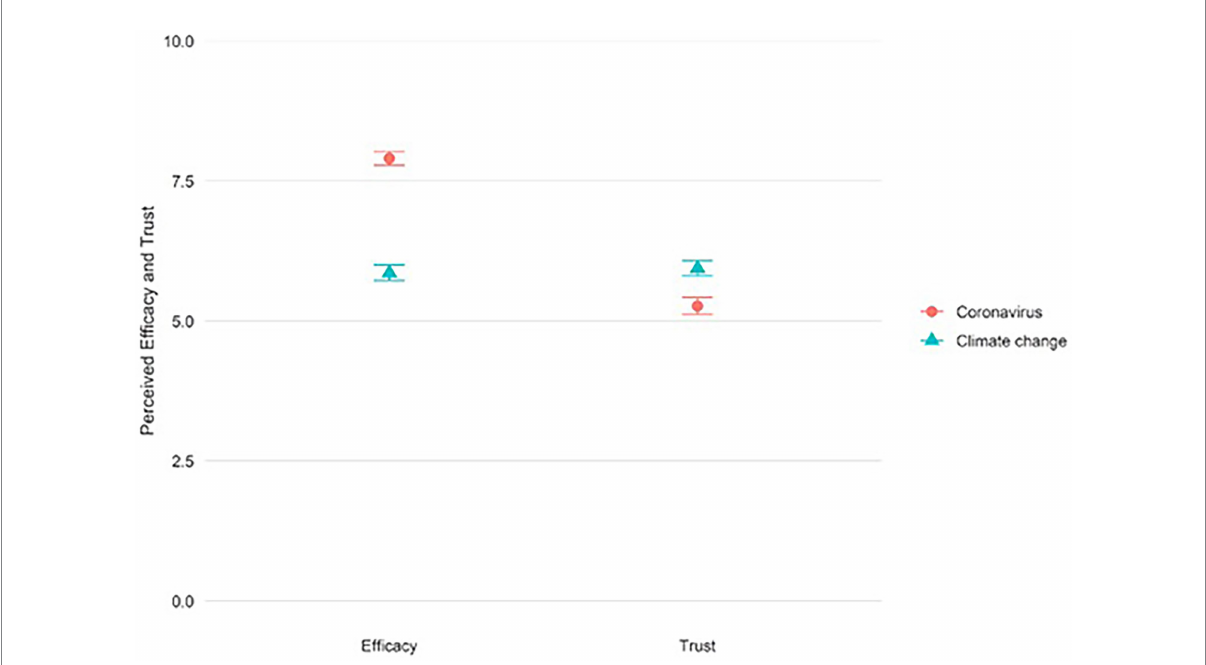
FIGURE 2 Mean scores for efficacy of personal actions, and trust in government to try to prevent coronavirus from spreading (circle) and climate change from worsening (triangle). Error bars reflect the 95% confidence intervals (also see Supplementary Table